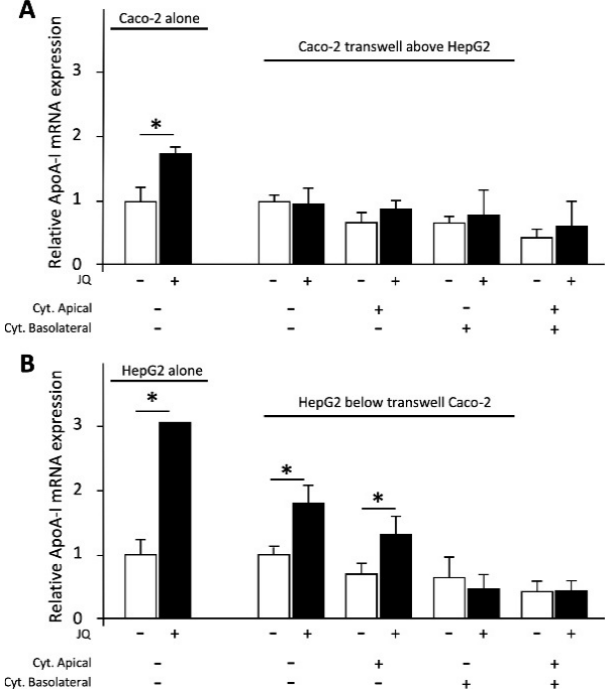
Figure 5. Relative Apolipoprotein A-I (ApoA-I) mRNA expressions in Caco-2 and HepG2 cells were cultured in a transwell system and treated with the positive control JQ1(+) (3 µM). ( A ) JQ1(+) significantly increased ApoA-I mRNA expression in Caco-2 cells that were cultured alone ( p < 0.05). JQ1(+) did not affect ApoA-I gene expression in Caco-2 cells co-cultured with HepG2 cells without cytokines or when cytokines were added to either apical, basolateral or both compartments. ( B ) JQ1(+) significantly increased ApoA-I mRNA expression in HepG2 cells that were cultured alone ( p < 0.01). JQ1(+) significantly increased ApoA-I mRNA expression in HepG2 cells co-cultured with Caco-2 cells without cytokines or when cytokines were added to apical compartments ( p < 0.008). JQ1(+) did not affect ApoA-I gene expression in HepG2 cells co-cultured with Caco-2 cells when cytokines were added basolaterally or to both compartments. All results are presented as the mean, while error bars indicate standard deviations. Data were normalized against the expression observed in the control condition, which was arbitrarily set at 1. A Mann-Whitney U test was performed to evaluate JQ1(+) effects in Caco-2 or HepG2 cells that were cultured alone versus control conditions, in which a p -value < 0.05 was considered statistically significant. When evaluating the effects of JQ1(+) on ApoA-I mRNA expression in different pro-inflammatory cytokines conditions in HepG2 or Caco-2 cells, the Mann-Whitney U test was used with a correction for multiple comparisons, in which a p -value < 0.008 was considered statistically significant. Changes are indicated with * when the effect of JQ1(+) is significantly different from the control. The presence of cytokines was indicated with (+), while the absence of cytokines was indicated with ( − ). ApoA-I, apolipoprotein-I; mRNA, messenger RNA.